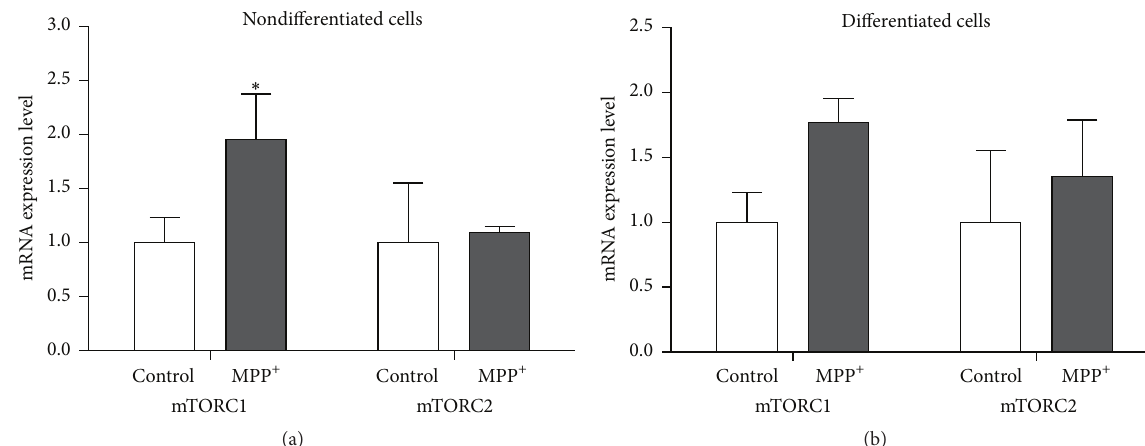
Figure 7: mRNA expression levels of mTORC1 and mTORC2 in nondifferentiated SH-SY5Y cells (a) and mRNA expression levels of mTORC1 and mTORC2 in differentiated SH-SY5Y cells (b). For neuronal differentiation, SH-SY5Y cells were treated with 10 𝜇 M retinoic acid for three days before exposure to MPP + . The control groups for nondifferentiated and differentiated SH-SY5Y cells were treated with the same medium without MPP + . Real-time quantitative PCRs were repeated three times in triplicate measurement. Data are expressed as relative to a control and shown as mean ± SEM. ∗ indicates 𝑃 < 0.05 versus control of each group.